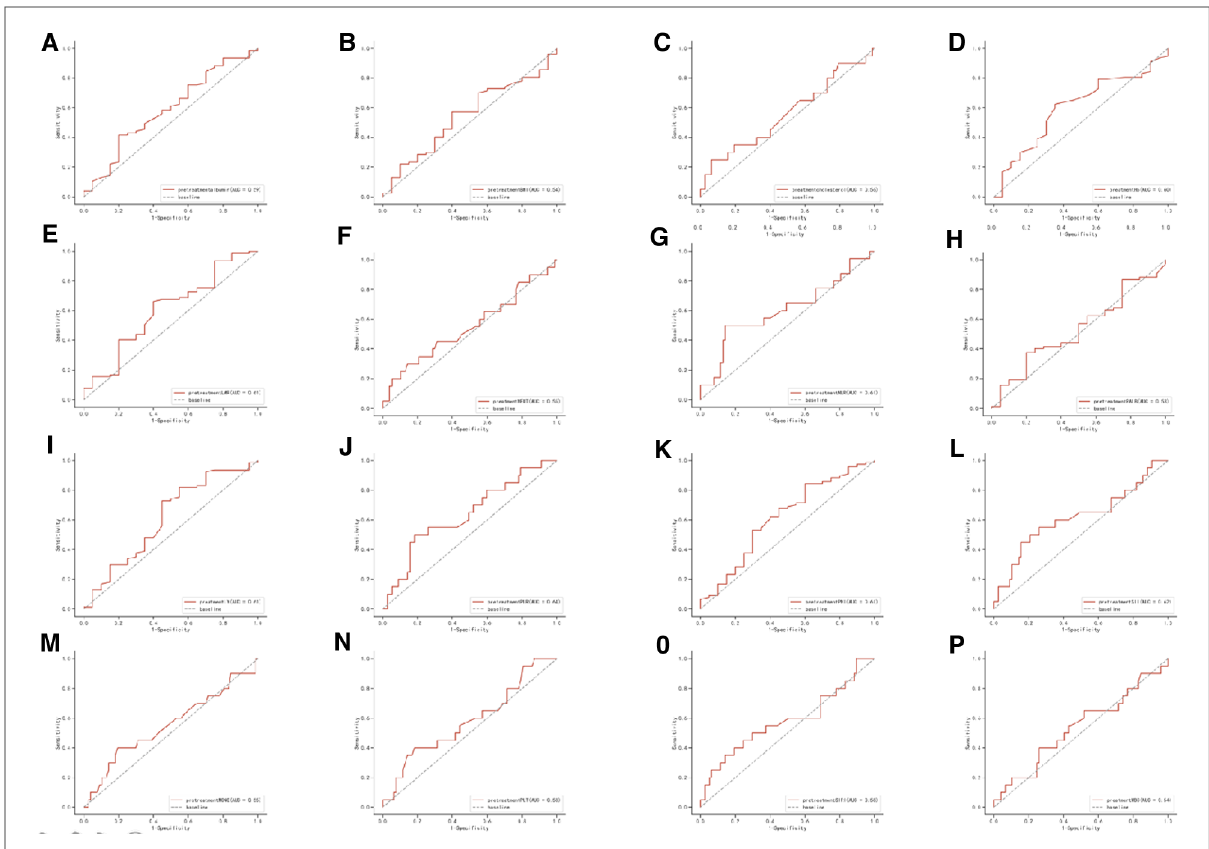
FIGURE 1 Receiver operating characteristic (ROC) of the following 16 predictive factors: HALP, SIRI, SII, PNI, PLR, LMR, NLR, BMI, PLT, Hb, MONO, LY, NEUT, WBC, cholesterol, and Alb.